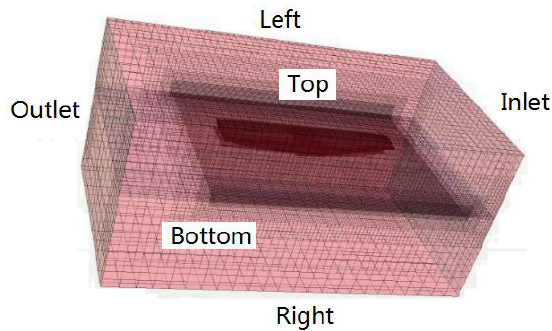
Figure 6. Sketch of the computational region.